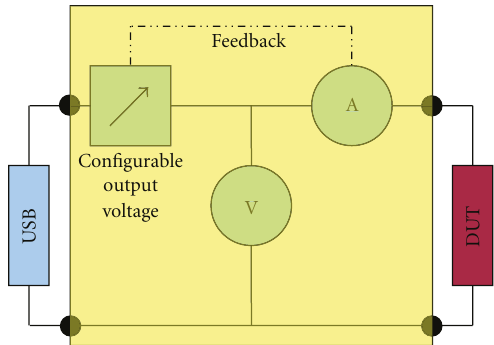
Figure 6: General principles of the energy-harvesting emulator. We measure the current consumed by the DUT, and we set the output voltage. The characteristics of the energy harvester and the storage element are implemented in